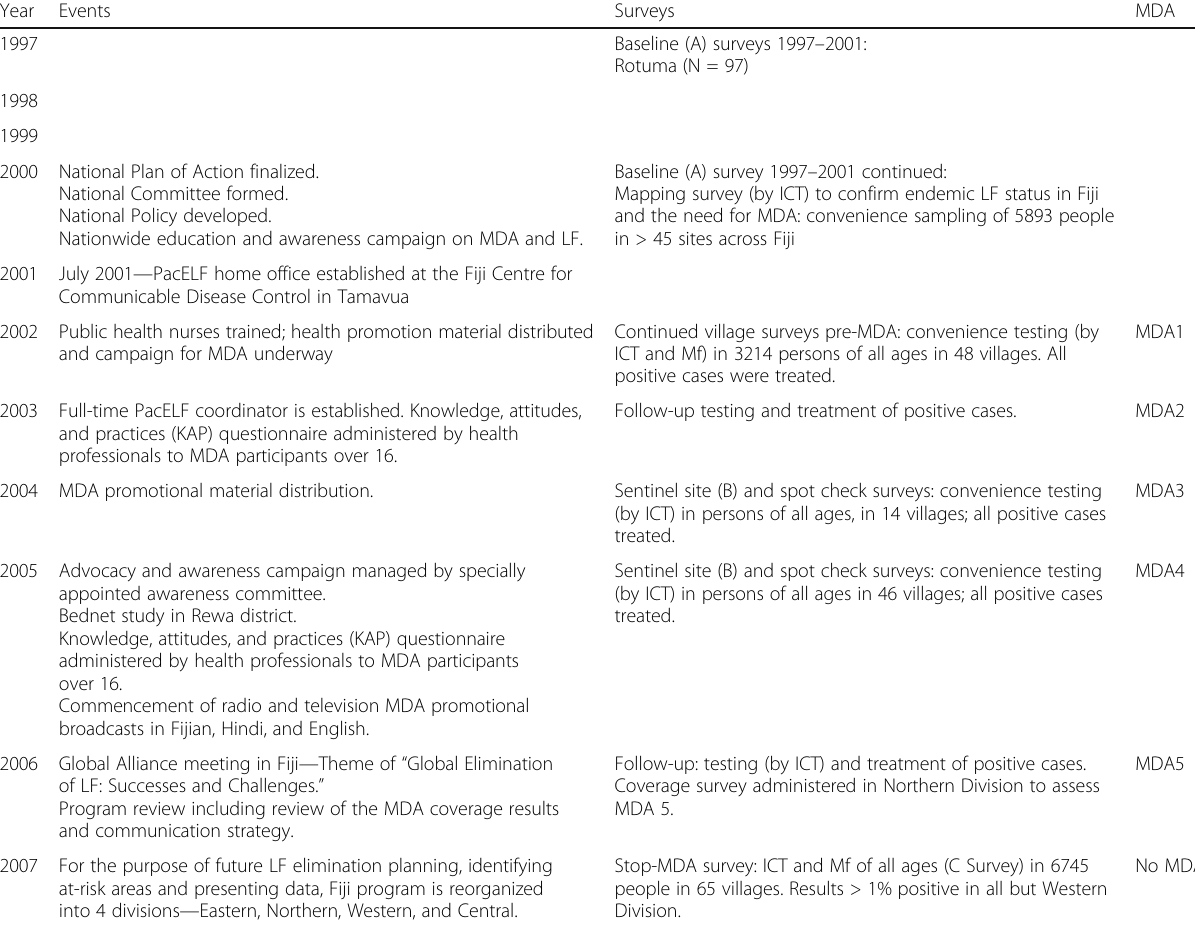
Table 1 Timeline of PacELF events, surveys, and MDA in Fiji 1997 – 2007